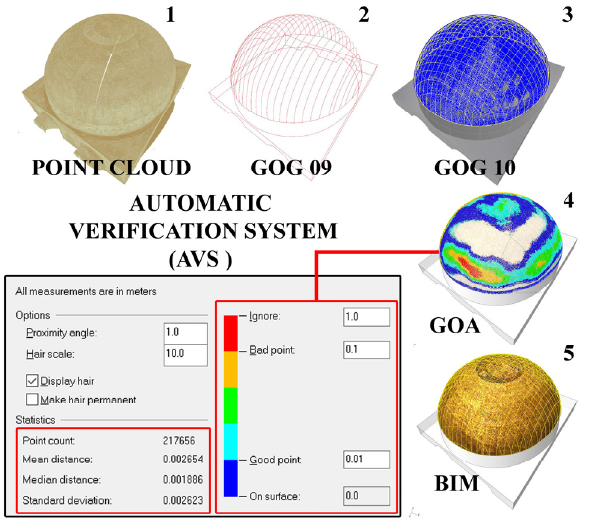
Fig. 6. The Automatic Verification System (AVS ) for ‘Scan to BIM’. Ciel d’Oro’ Vault, Basilica of Saint Ambrose, Milano. (1) Point Cloud, (2) GoG9 - NURBS from 3D Wireframe, (3) GoG10 - NURBS from a point cloud, (4) GoA – Median Distance is 0,00188 6m, Mean Distance 0,002654, Standard Deviaton is 0,002623 m, Point Count 217556, (5) BIM of vaulted